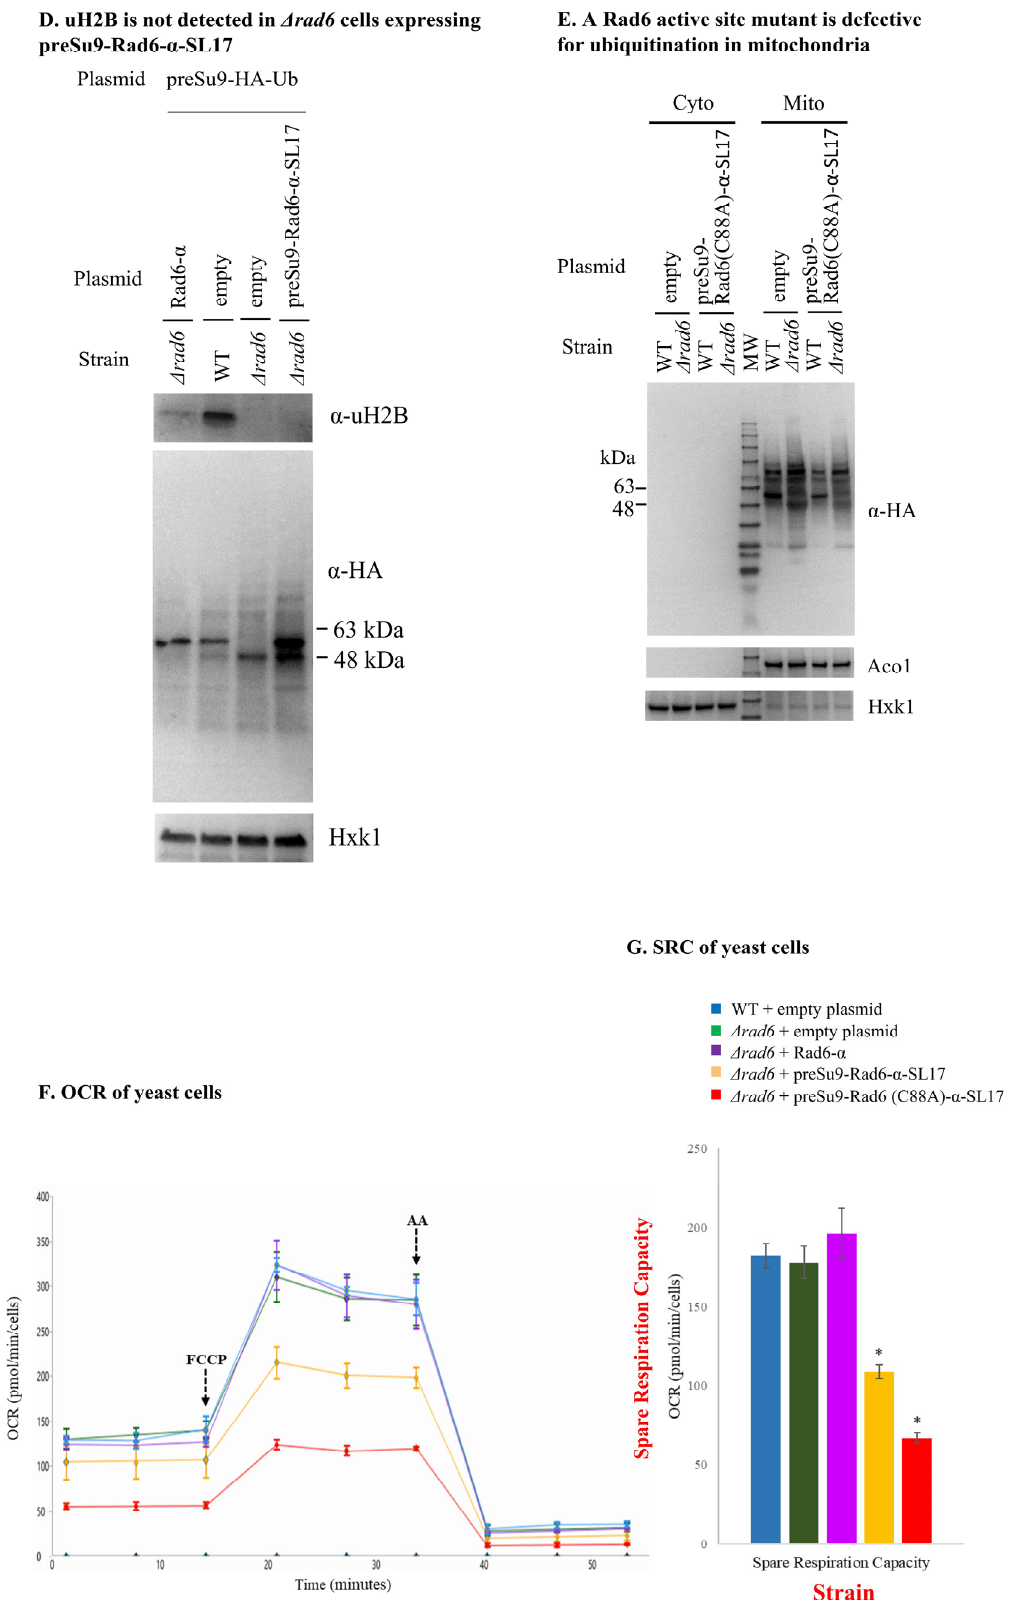
Figure 7. Rad6 is active in protein ubiquitination in mitochondria. ( A ) α -complementation assay for preSu9-Rad6- α and preSu9-Rad6- α -SL17 fusion proteins. N-terminal 40 amino acids of cytosolic